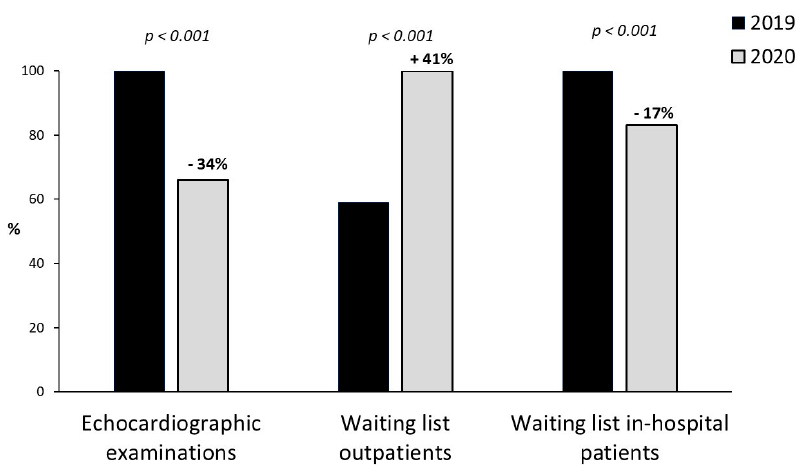
Figure 1. Percentage difference from November 2019 (black bar) to November 2020 (gray bars) in echocardiographic examinations, waiting list outpatients and waiting list in-hospital patients.